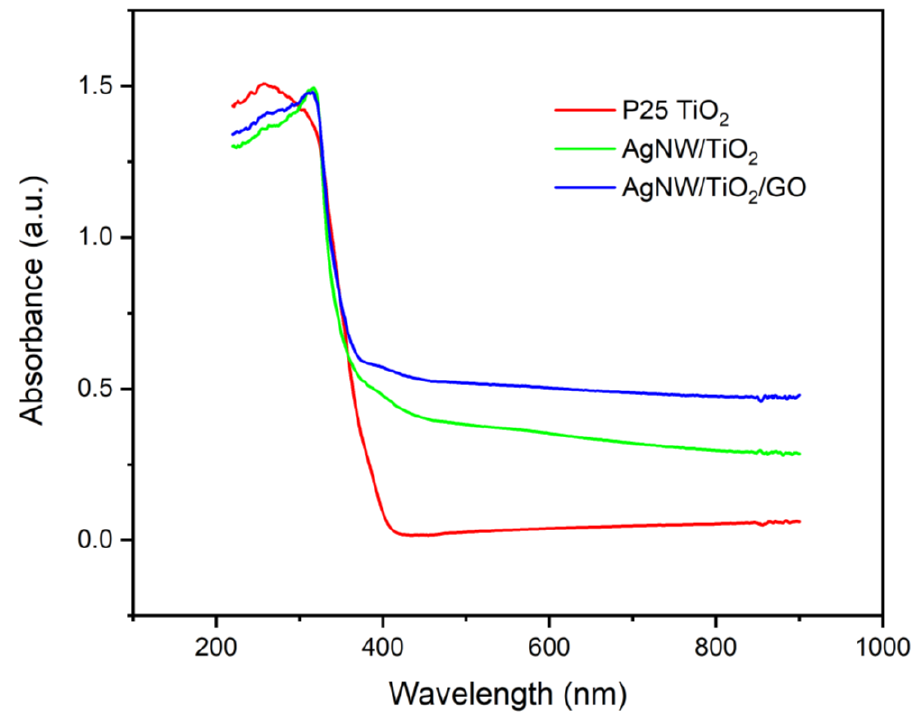
Figure 5. UV-VIS spectra of P25 TiO 2 , AgNW/TiO 2 , and AgNW/TiO 2 /GO nanocomposite samples.